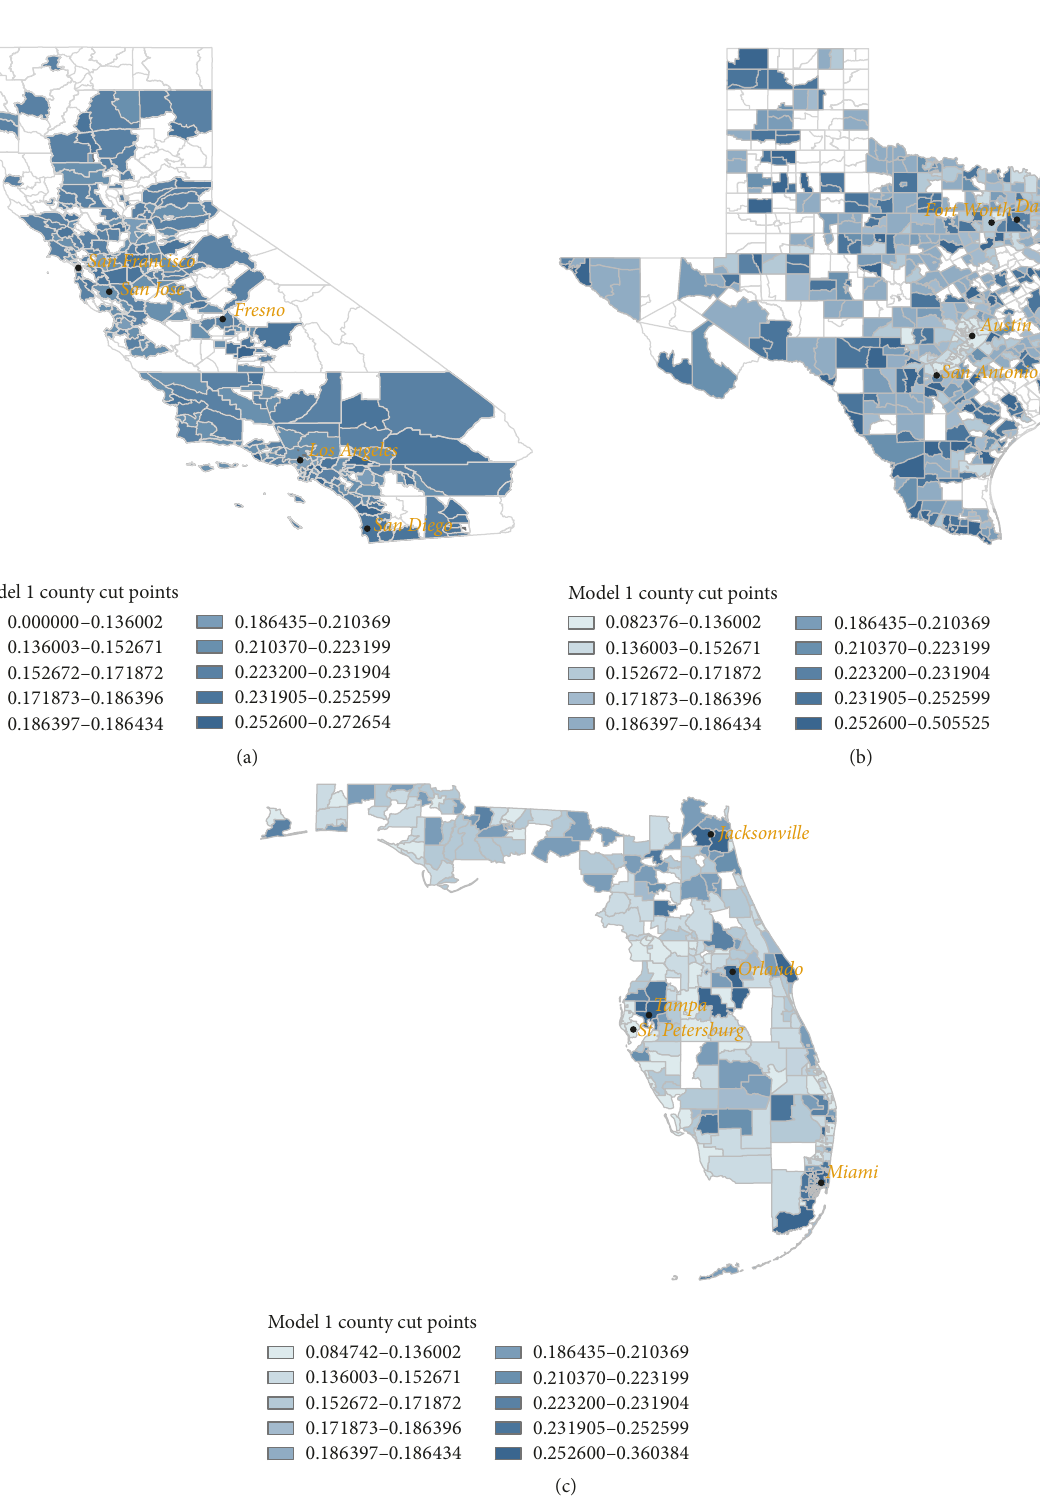
Figure 1: Spatial distribution of late stage diagnosis. ((a)–(c)) Each map depicts the prevalence of late stage melanoma diagnosis in Hispanic men in California, Texas, and Florida, respectively. Maps were generated using the Geographic Information System (GIS). All 𝑃 values less than 0.05 were considered statistically